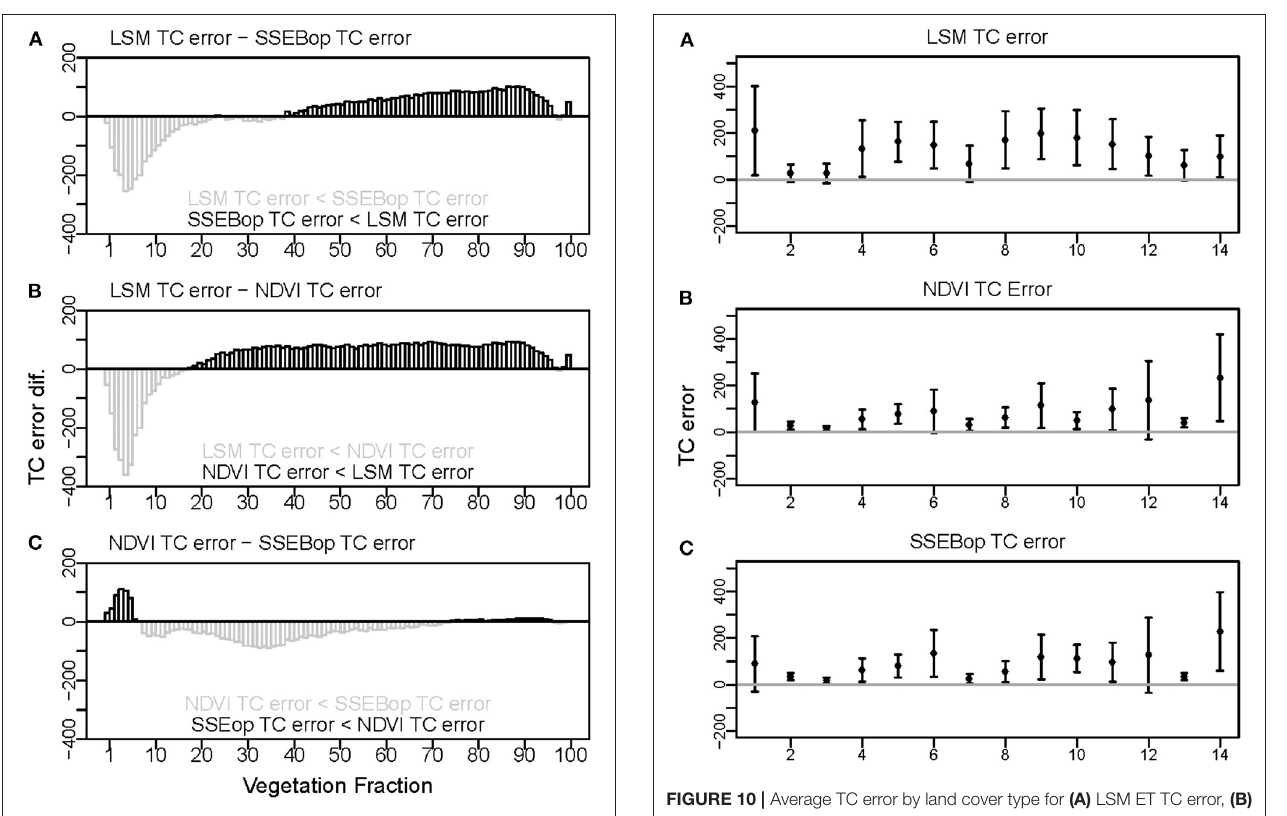
in East Africa. However, there are differences in magnitude between them. LSM ET and SSEBop ET were found to be better indicators for vegetation monitoring during the